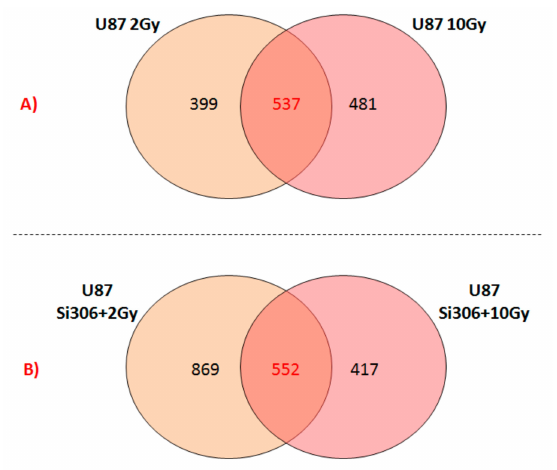
Figure 2. Venn diagrams showing the number of unique and shared di ff erentially expressed genes after exposure to: ( A ) PT and ( B ) Si306 + PT combined